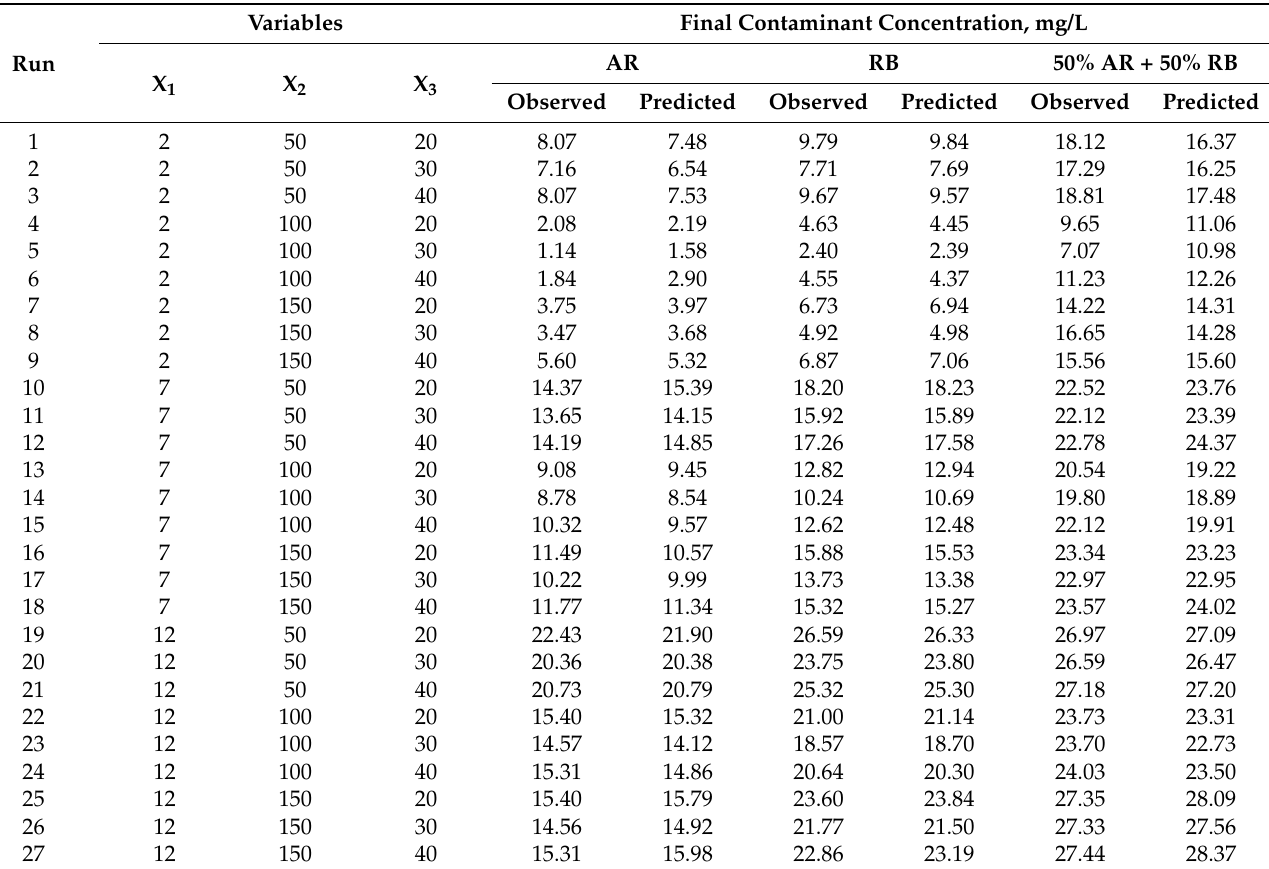
Table 1. RSM-CCD matrix including experimentally obtained and model-predicted